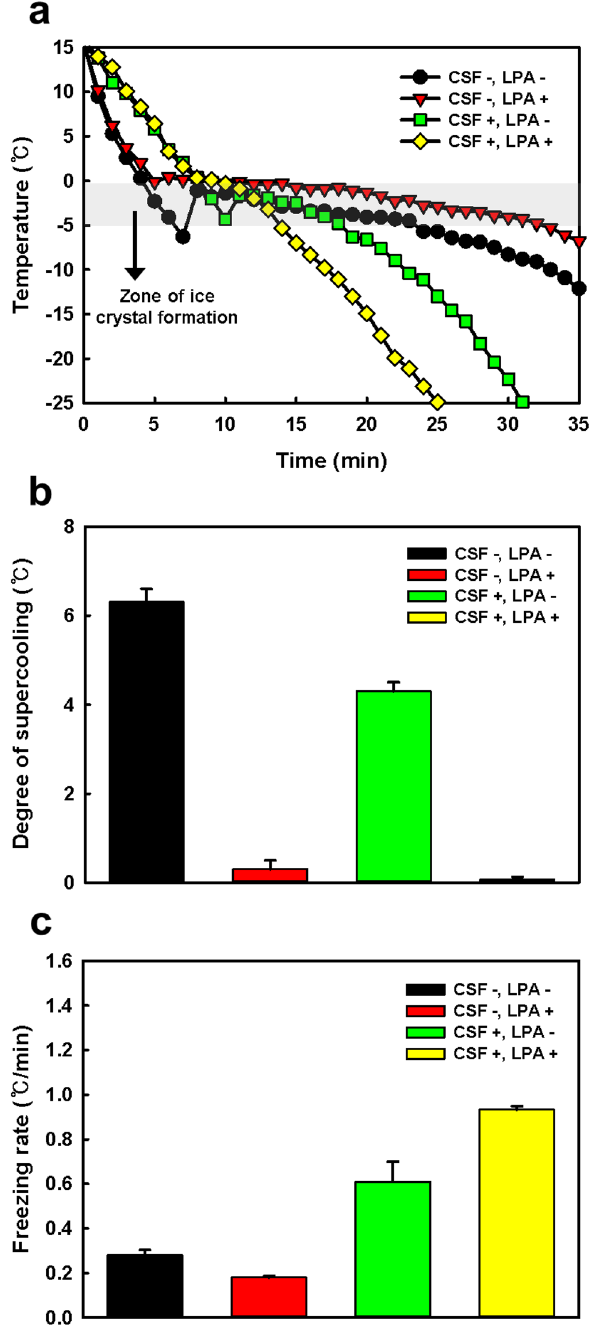
Figure 1. Effects of CSF and LPA on the freezing behavior of the lipid nanovesicle solution. ( a ) Temperature profiles, ( b ) degree of supercooling, and ( c ) freezing rate under different freezing conditions. Isopropanol was used as the liquid medium for the CSF system. The freezing rate was measured within the zone of ice crystal formation (− 5 to 0